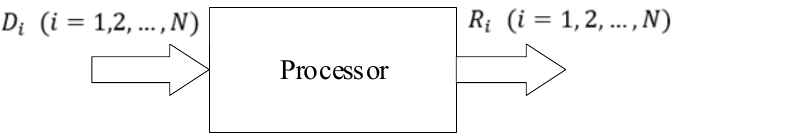
Figure 1. Streaming algorithm graph.